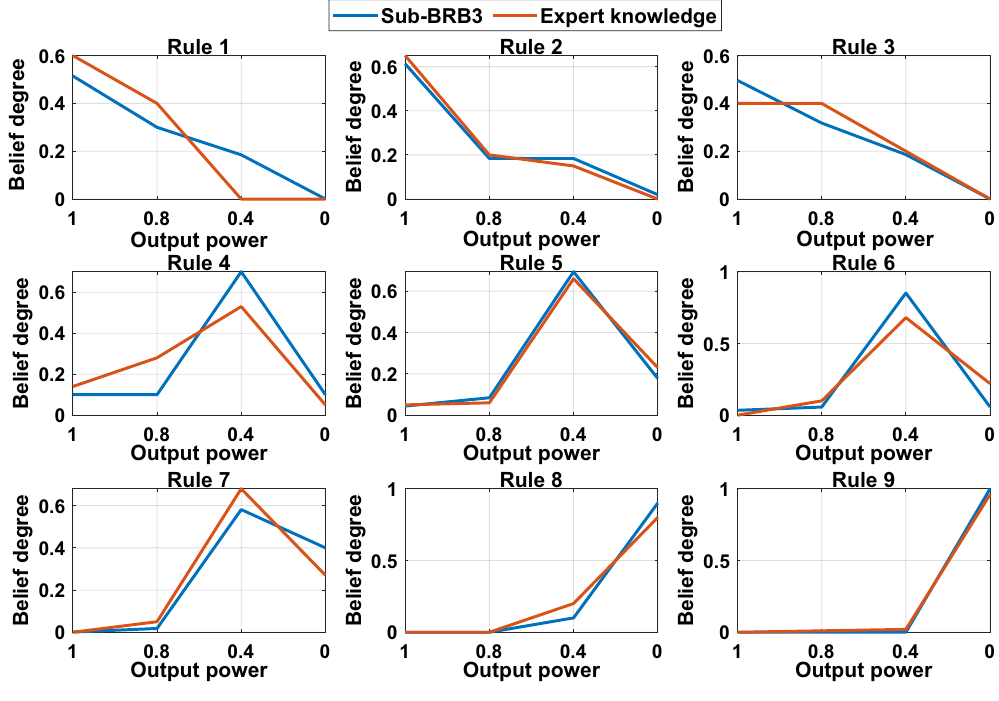
Figure 19. The belief distribution of Sub-BRB3.